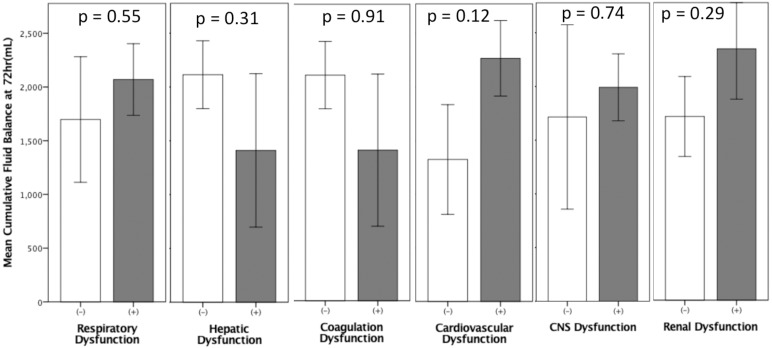
Comparison of 72-hr cumulative fluid balance (CFB) between patients with and without individual organ dysfunction.No significant difference in 72-hr CFB was observed between patients with and without individual organ failure (p values analyzed using Student t test; data expressed as mean ± SEM).